Question: Which kind of chart has been used to present this data?
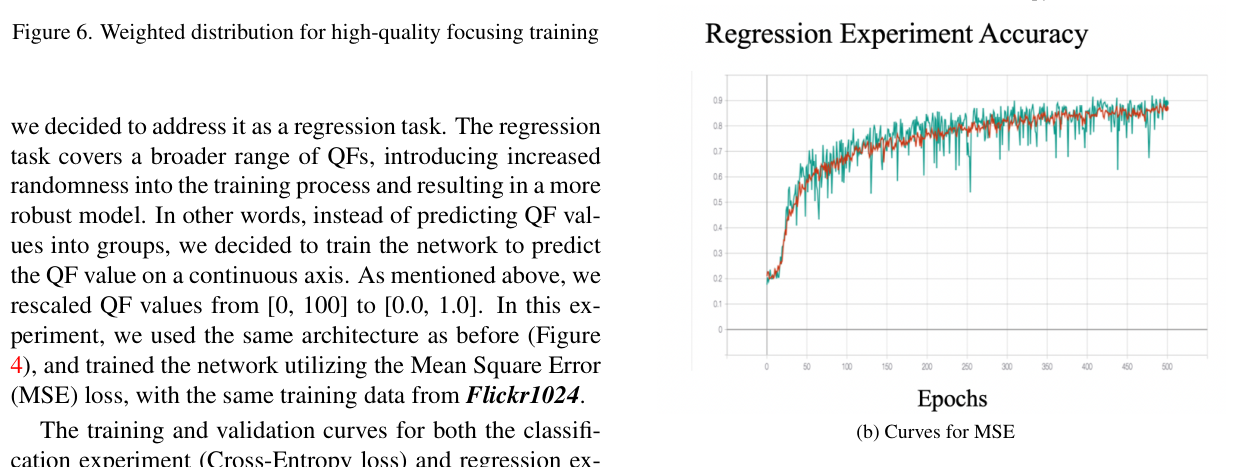
Answer: line